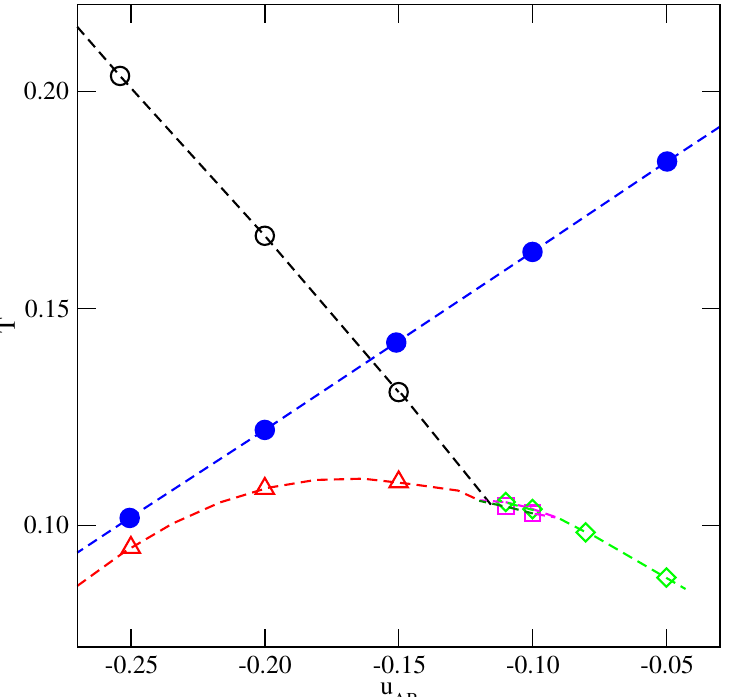
Figure 16. The changes of the T c ( u AB ) , (circles), T trc ( u AB ) (triangles), T cep ( u AB ) (diamonds), T tr ( u AB ) (squares), and T o ( u AB ) (filled circles) estimated for the series with u BB =